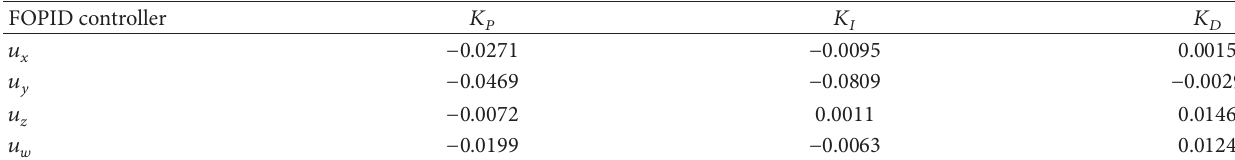
Table 1: FOPID controller gain values optimized with GA.